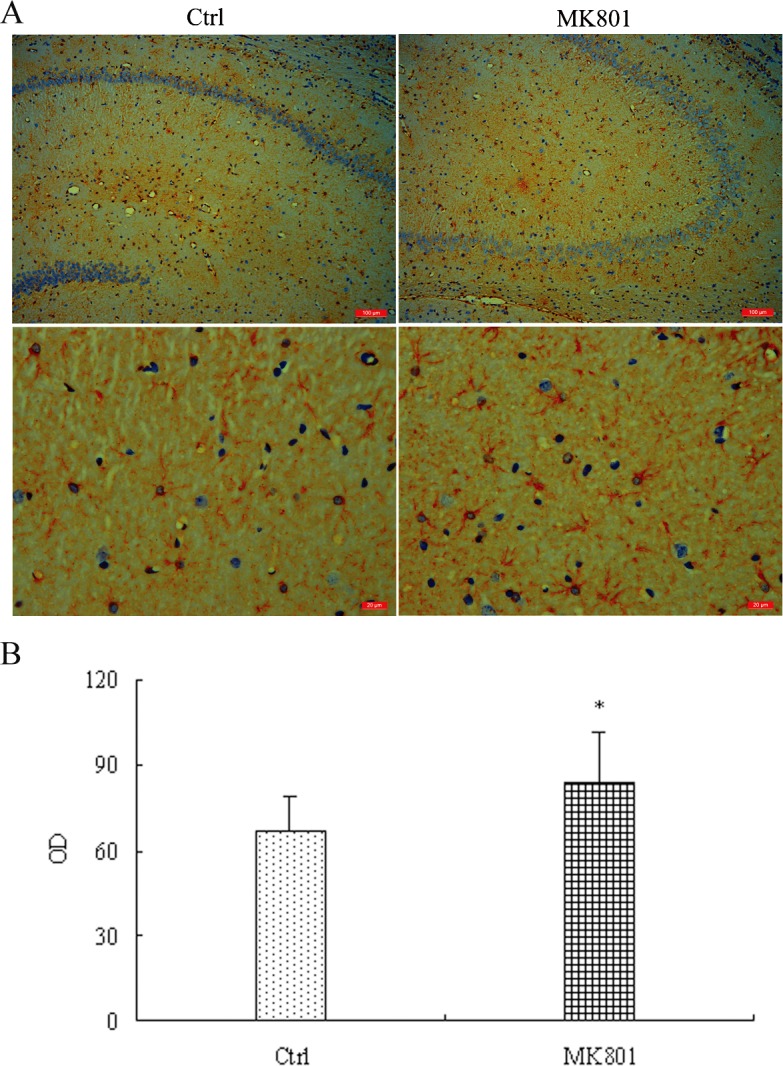
Enhanced GFAP immunoreactivity in hippocampal astrocytes of MK-801-treated rats.MK-801 was administered by intraperitoneal injection (0.5 mg/10ml/kg body weight) daily for 6 days. Control (Ctrl) animals received equal volumes of normal saline. (A) Extensive positive cellular labeling of GFAP was seen in MK801-induced rat hippocampus (n = 4 rats per group) while only mild positive staining was observed in control group. (B) Computer assisted image analysis revealed significantly increased GFAP expression in MK-801-treated rats compared to saline-treated rats. OD = optical density. Data are the mean±S.E.M. Statistical differences between two groups were determined by student's t-tests. *P <0.05 vs. control group.